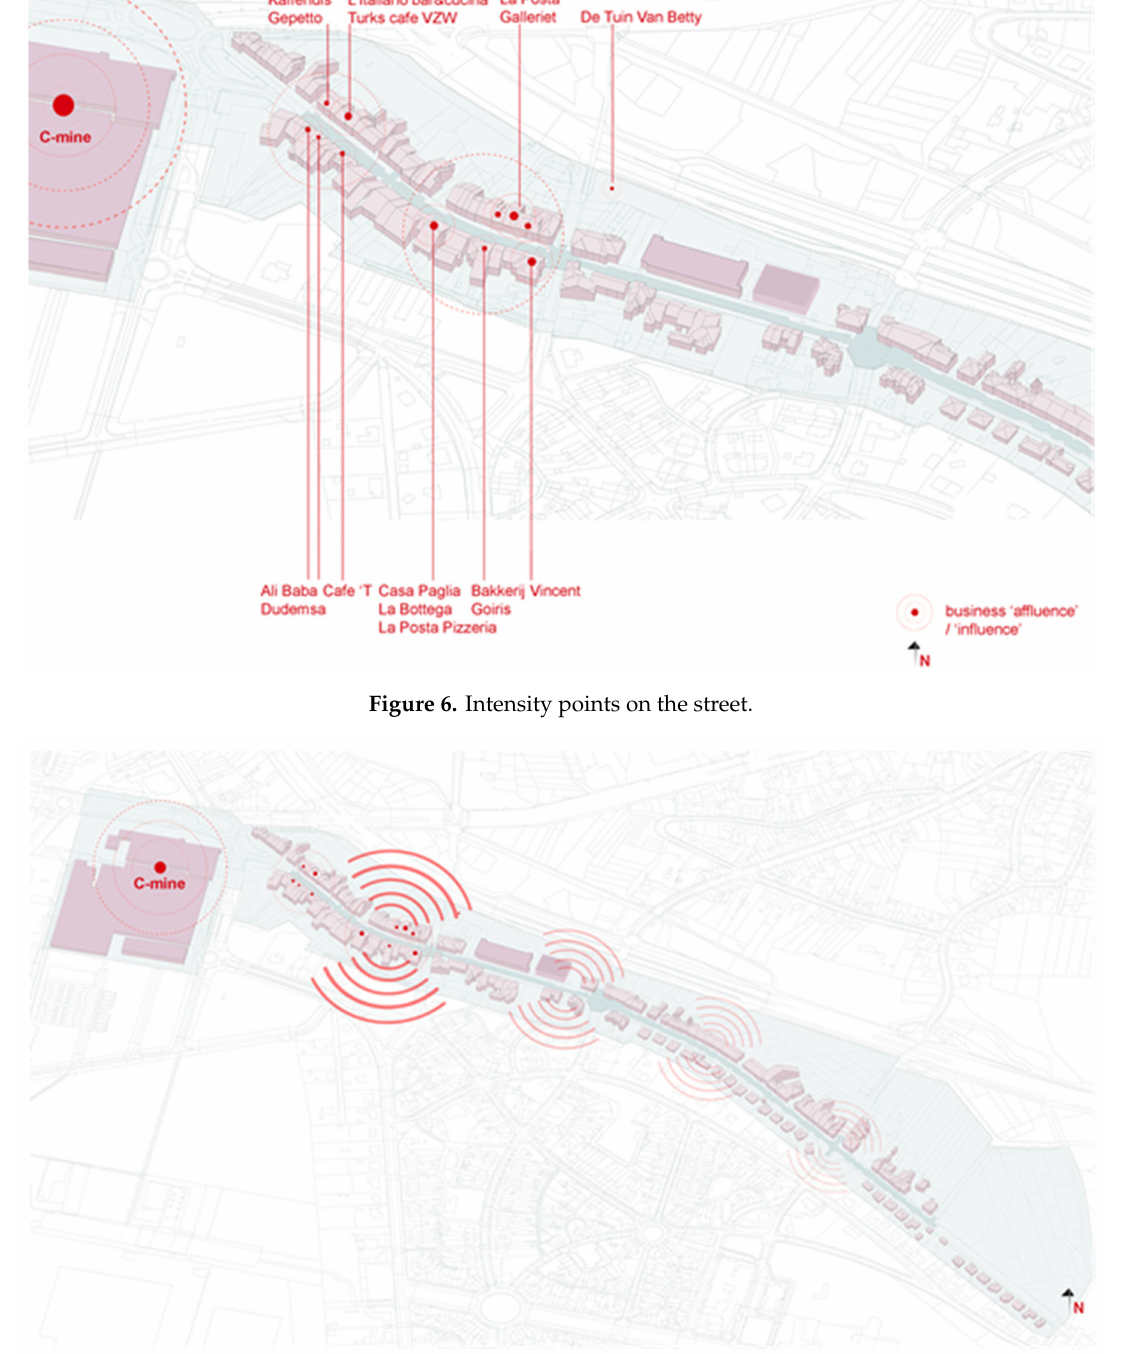
Figure 7. Business influence / a ffl uence: representative